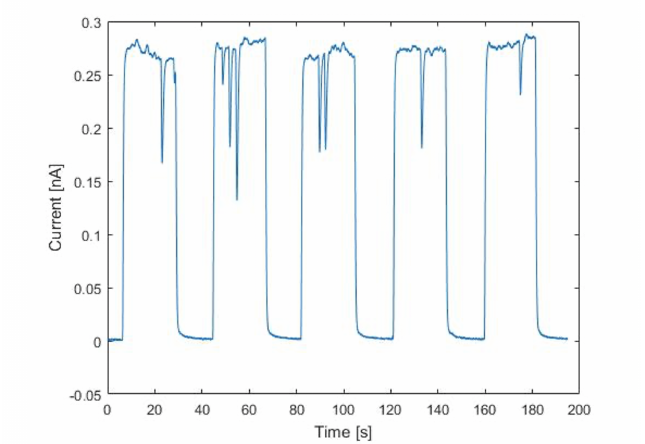
Figure 2. Detector current output for five consecutive proton irradiations. Each positive signal corresponds to a nominal dose of 4 Gy released at the water-tank